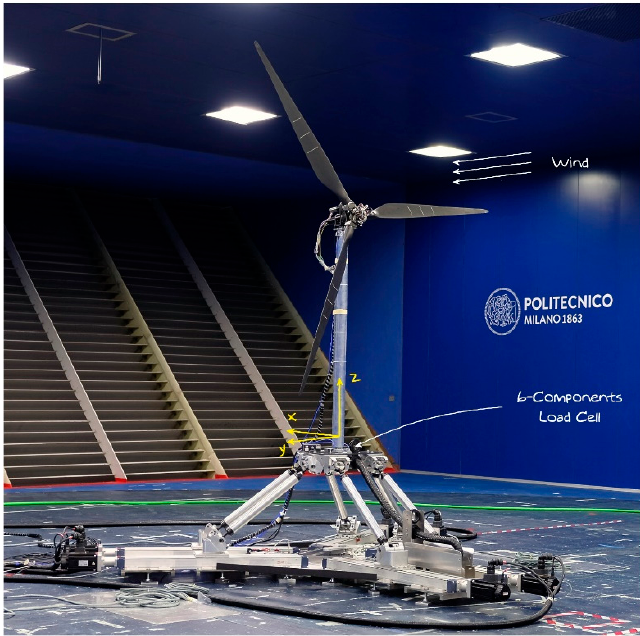
Figure 6. Experimental project selecting floating platforms and mooring systems as the numerical structures ( Reprinted/adapted with permission from Ref. [61]. 2020, Belloli, M. ).